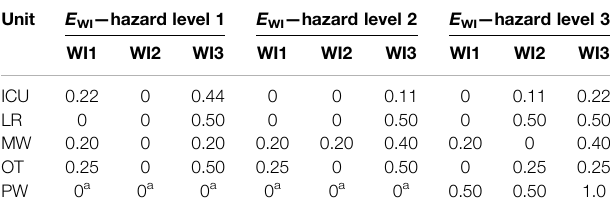
TABLE 7 | Summary of the effectiveness of each What-If (WI)